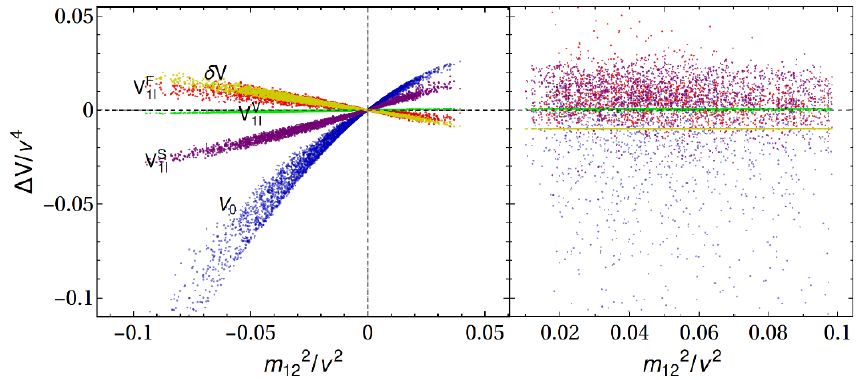
Figure 6 . Potential di(cid:11)erence of the two coexisting minima against m 2 potential (2.1) is considered. This plot should be compared with (cid:12)gure 1. Right : the full 1-loop e(cid:11)ective potential (4.3) is considered. The green points represent a change in sign of the tree level prediction for the potential di(cid:11)erence.